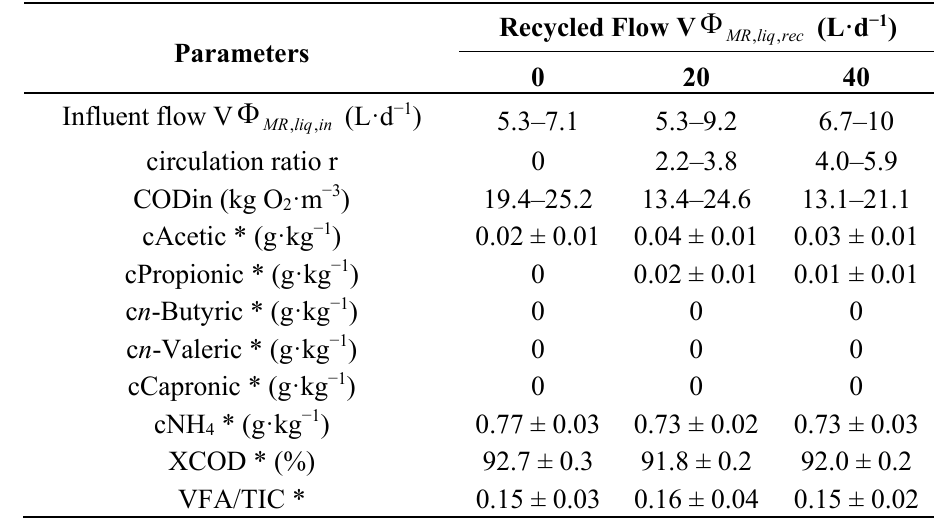
Table 2. Characteristic parameters of the process